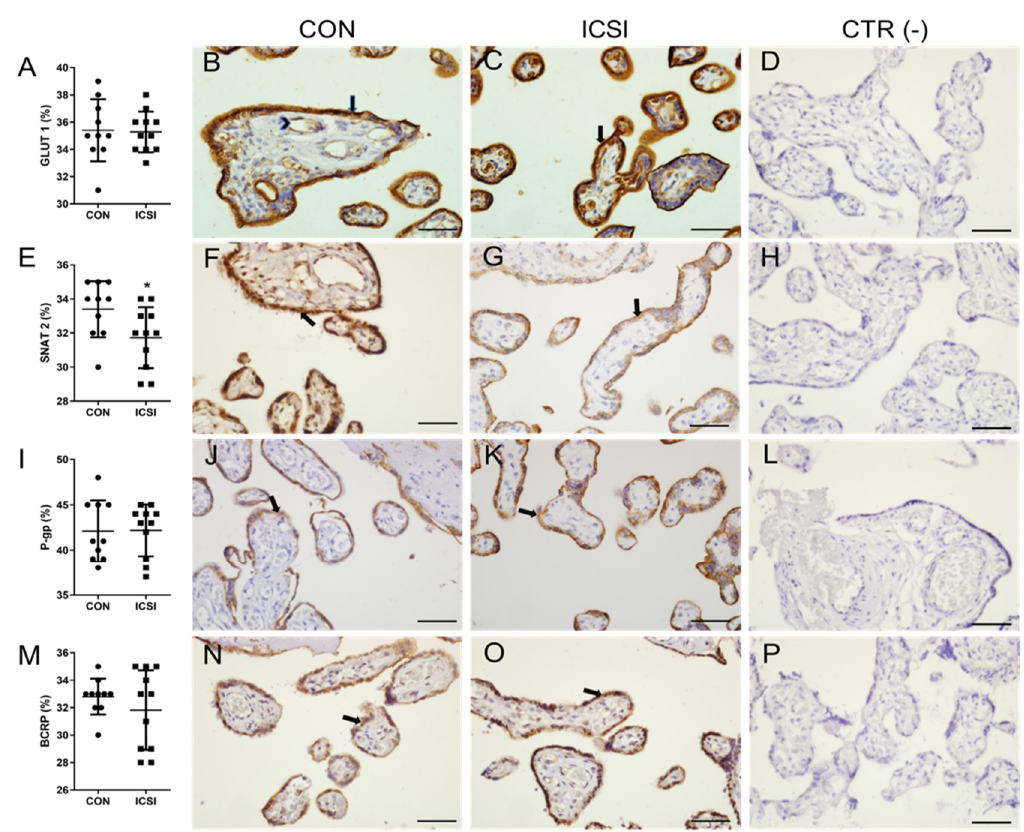
Figure 1. The amino acid transporter SNAT2 is downregulated in the human ICSI placenta. Semiquantitative staining scores ( A , E , I , M ) and corresponding representative immunostaining photomicrographies of placental GLUT1 ( B , C ), SNAT2 ( F , G ), P-gp ( J , K ) and BCRP ( N , O ) in control naturally conceived (CON; n = 10/group) and ICSI ( n = 11/group) term placentae. All transporters were predominantly localized to the membrane and cytoplasm of syncytiotrophoblasts. Staining of GLUT1, SNAT2 and BCRP were also detected, to a lesser extent, in endothelial cells of fetal blood vessels and in the cytoplasm of placental connective tissue. ( D , H , L , P ) negative controls. Data are presented as media ± SD. ( A , E , I , M ) statistical differences were analyzed using Unpaired t -test. * p < 0.05. Arrows indicate the syncytium; arrow heads indicate fetal blood cells. Scale bar = 50 μ m.